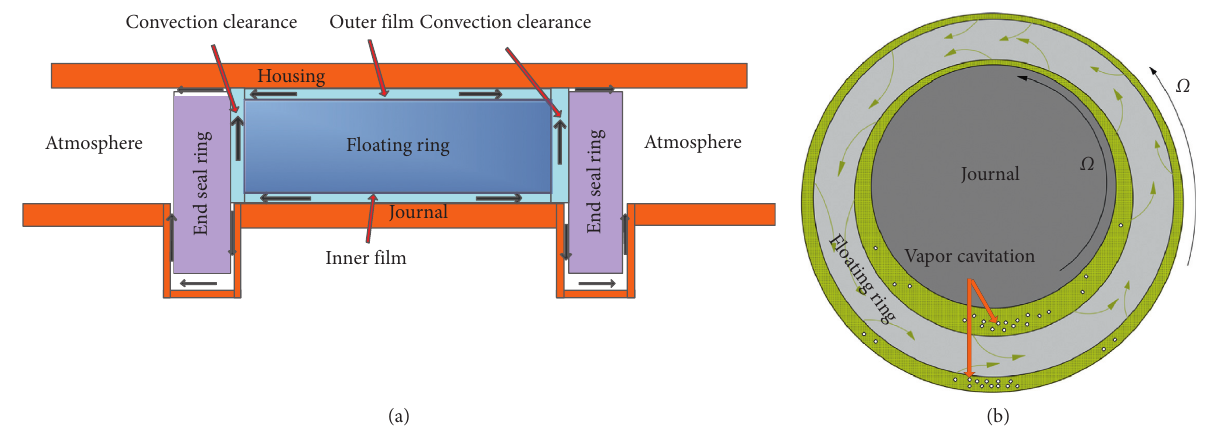
Figure 3: Schematic diagram for DCSFD convection: (a) front; (b)